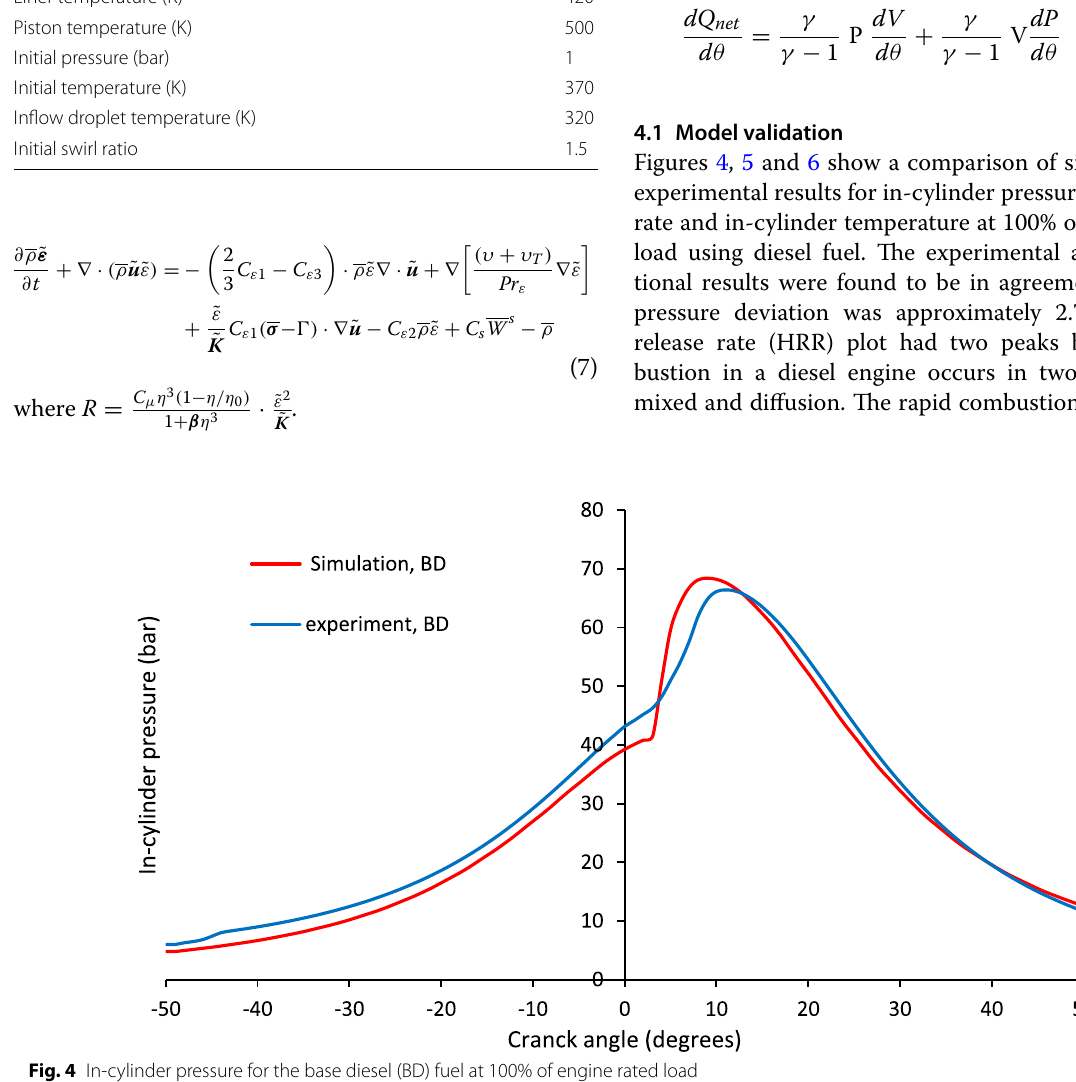
Fig. 4 In‑cylinder pressure for the base diesel (BD) fuel at 100% of engine rated